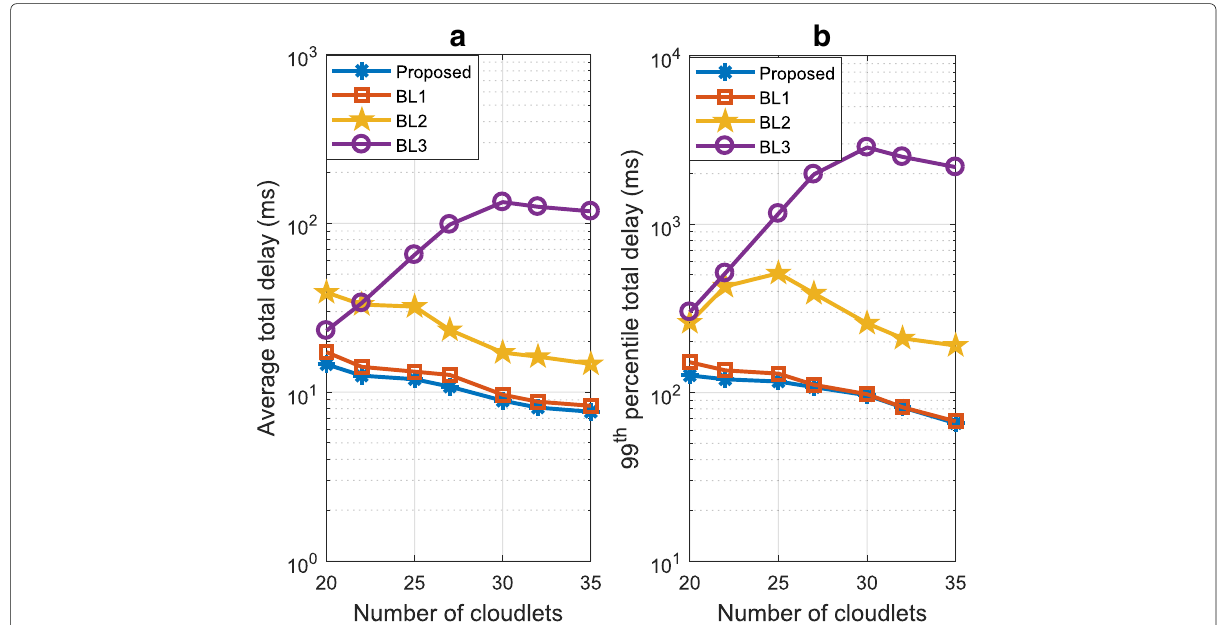
Fig. 4 The delay performance vs. network density. a The average delay and b the 99th percentile delay performance for different network densities, with E = 30 cloudlets, and UN density U / E =